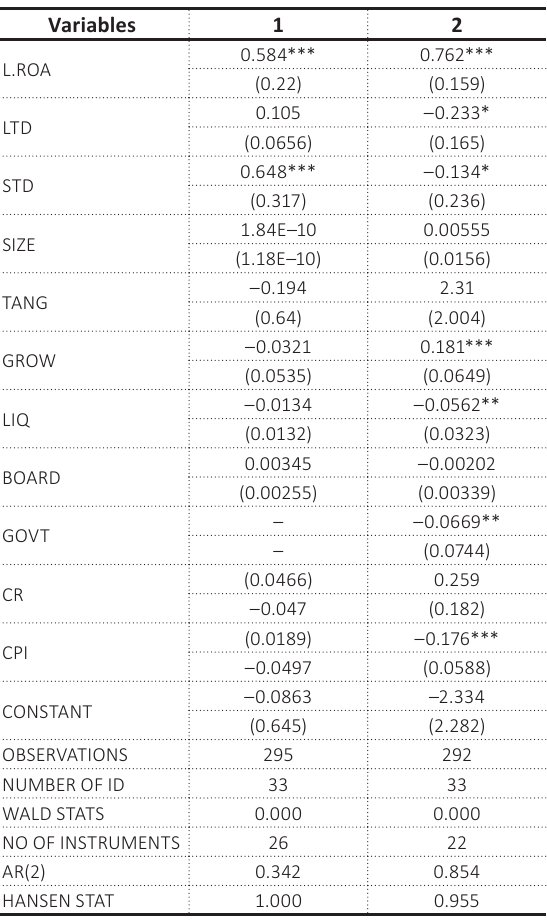
Table 3. Regression